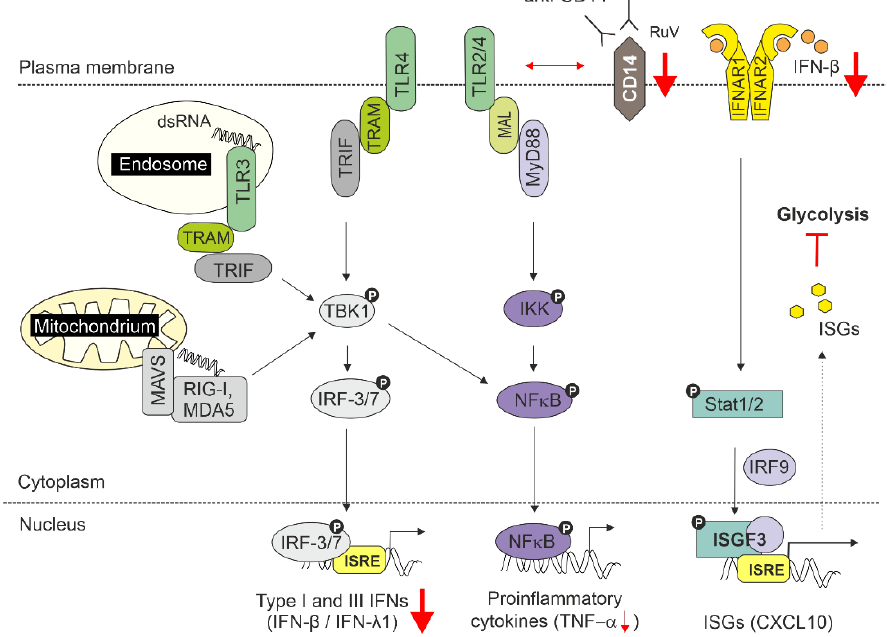
Figure 5. Summarizing figure. CD14-dependent signalling contributes to the induction of IFNs during RuV infection and potentially involves a so far unidentified TLR. As recently outlined in a review, among the TLRs involved in recognition of viral PAMPs are TLR2 and TLR4 (envelope glycoproteins) and TLR3 (dsRNA) [38]. For simplification, internalization and localization of TLR2 and TLR4 to endosomes are not depicted. All TLRs use the adaptor MyD88 except for TLR3, which signals only through TRIF. TLR3 and TLR4 interact with the adaptor TRIF. As the PRR for RuV is still unknown, RIG-I and MDA5 are included as additional PRRs for dsRNA within the cytoplasm. The associated transcriptional pathways, NFkB and IRF3/7, are illustrated. Through its association with TLRs, CD14 modulates the activation of downstream signalling pathways. The noted reduction in IFNs after application of blocking antibodies prior to RuV infection points towards the involvement of TRIF-dependent pathways during RuV infection. Downmodulated targets are highlighted with red arrows. The inhibitor symbol indicates the here identified inhibition of glycolysis by IFN- β.